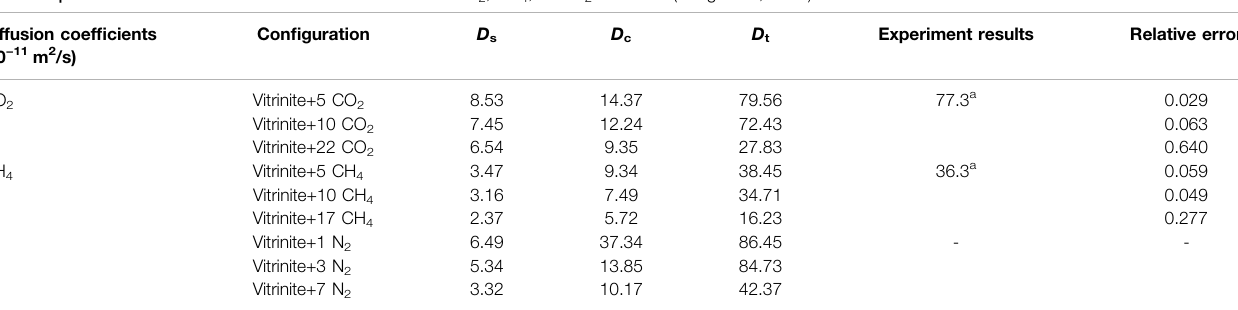
TABLE 2 | Three diffusion coef fi cients for different amounts of CO 2 , CH 4 , and N 2 in vitrinite (Song et al., 2018). Diffusion coef fi cients (10 − 11 m 2